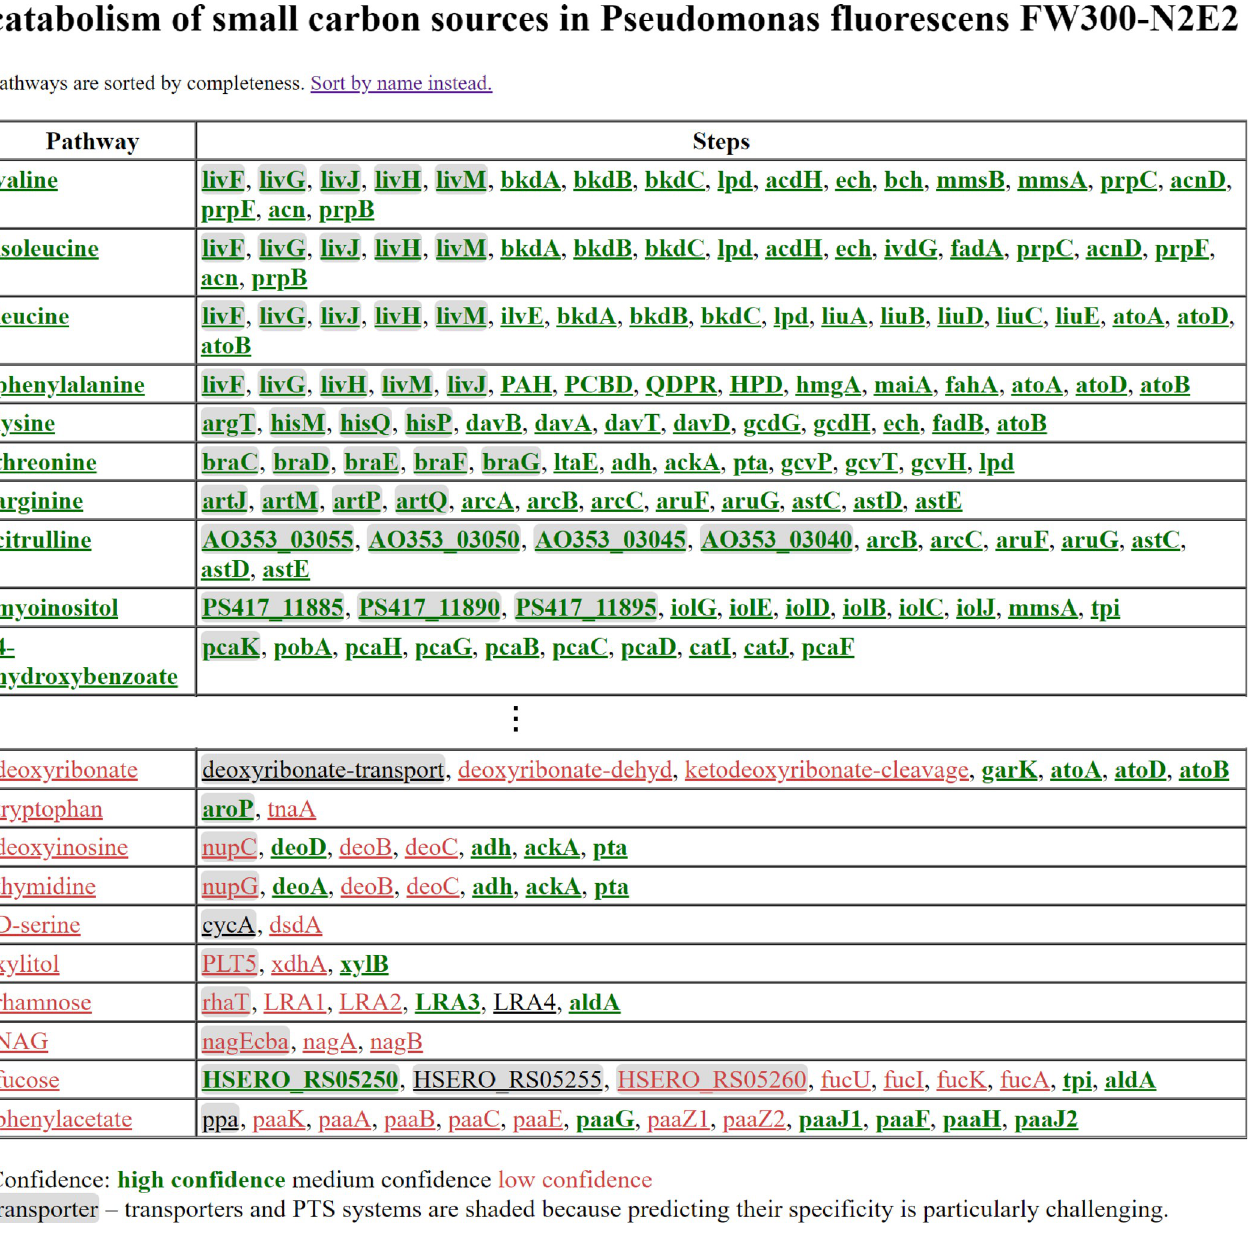
Fig 2. Example results for Pseudomonas fluorescens FW300-N2E2. A page on the GapMind website shows the 62 compounds in order; this figure shows screenshots for the first 10 (highest-scoring) and last 10 (lowest-scoring) carbon sources. Hovering on a step shows the description and the best candidate, if any. (Some transporter components are named by the genes’ locus tags; none of these locus tags are from P . fluorescens FW300-N2E2 itself.) Clicking on a step shows all the candidates for that step. Clicking on a compound shows alternate pathways.